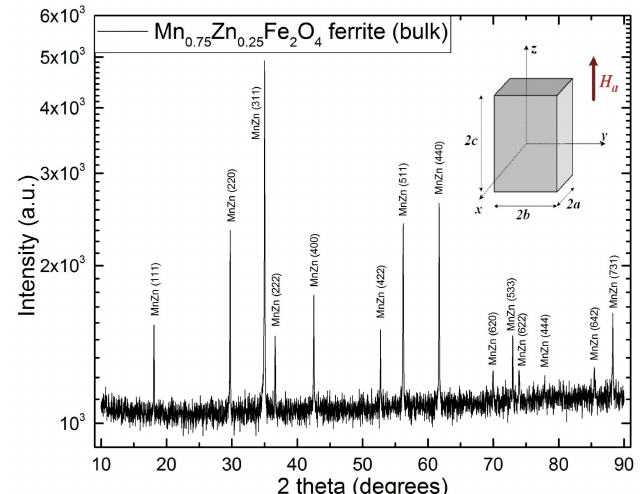
Figure 4. X-ray di ff ractogram (XRD) of the MnZn ferrite revealing the poly-oriented and polycrystalline structure; insert image: dimension of the cut samples to be measured by the vibrating sample magnetometry (VSM) technique, and direction of the applied magnetic